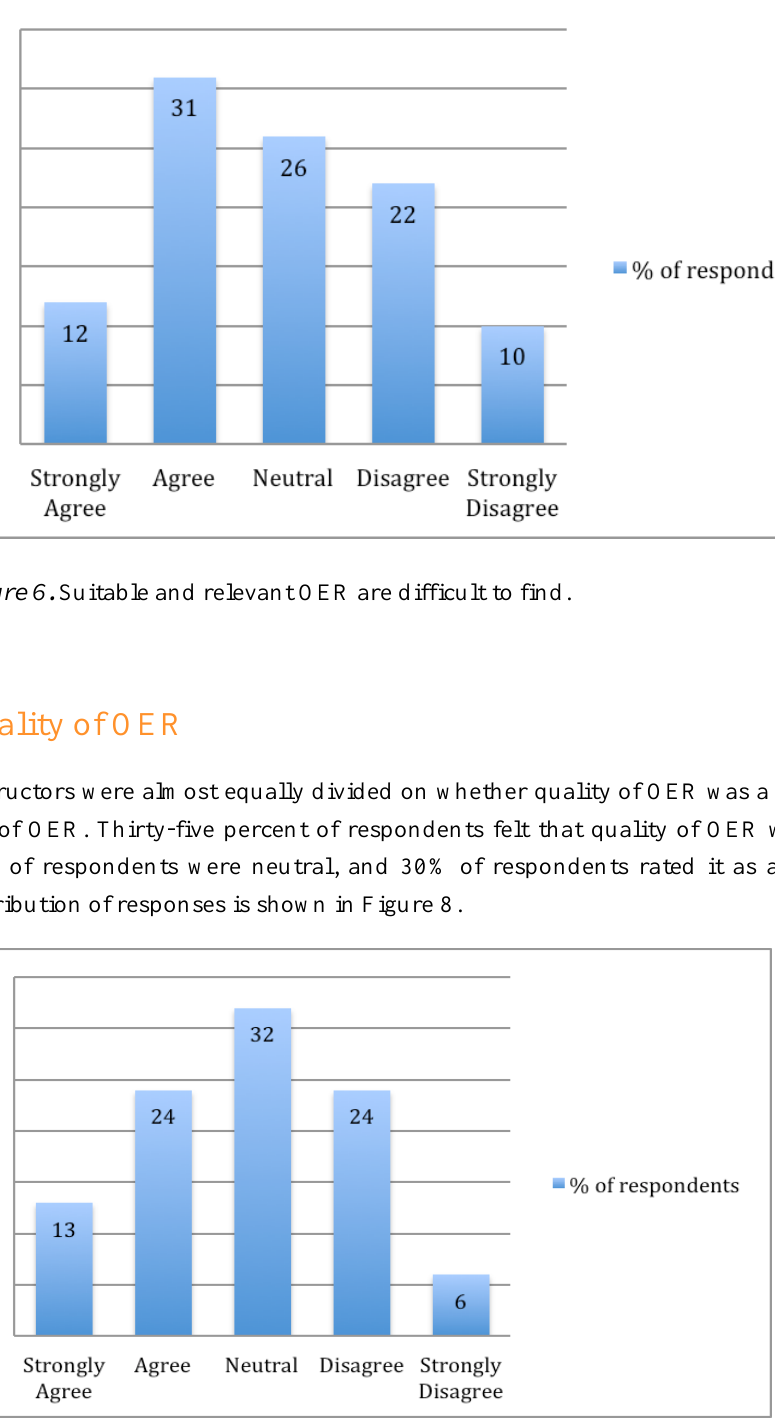
Figure 7. Quality of